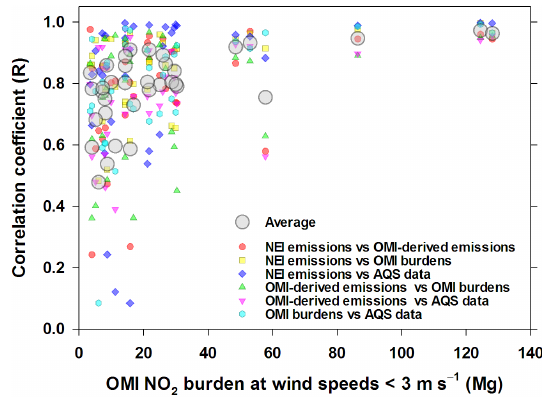
Figure 7. Correlation coefficients of pair-wise trends among the NEI NO x emissions, the OMI-derived NO x emissions, the OMI NO 2 burdens at wind speeds <3ms − 1 , and the AQS NO 2 mea- surements against the mean OMI NO 2 burdens under the weak- wind-speed condition (<3ms − 1 ) for all selected urban areas during 2006*–2013*. Each large gray circle represents the average of the six correlation coefficients for an urban